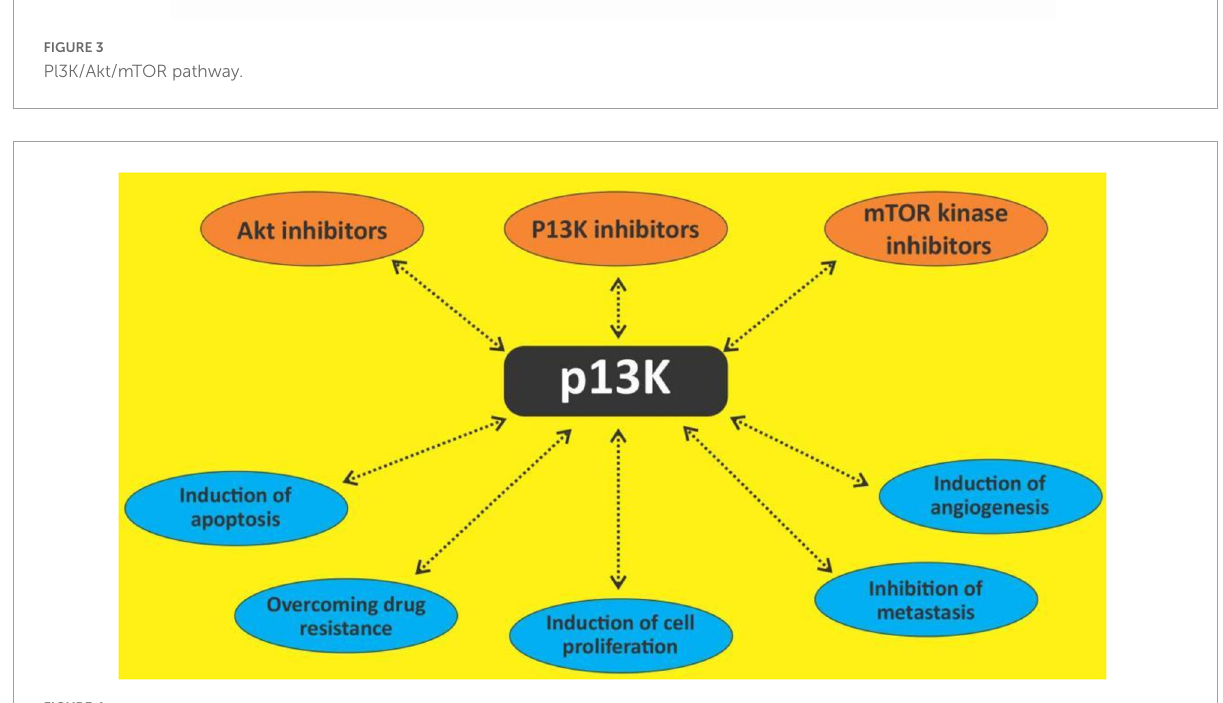
FIGURE4 Targeting Pl3K/Akt/mTOR with different